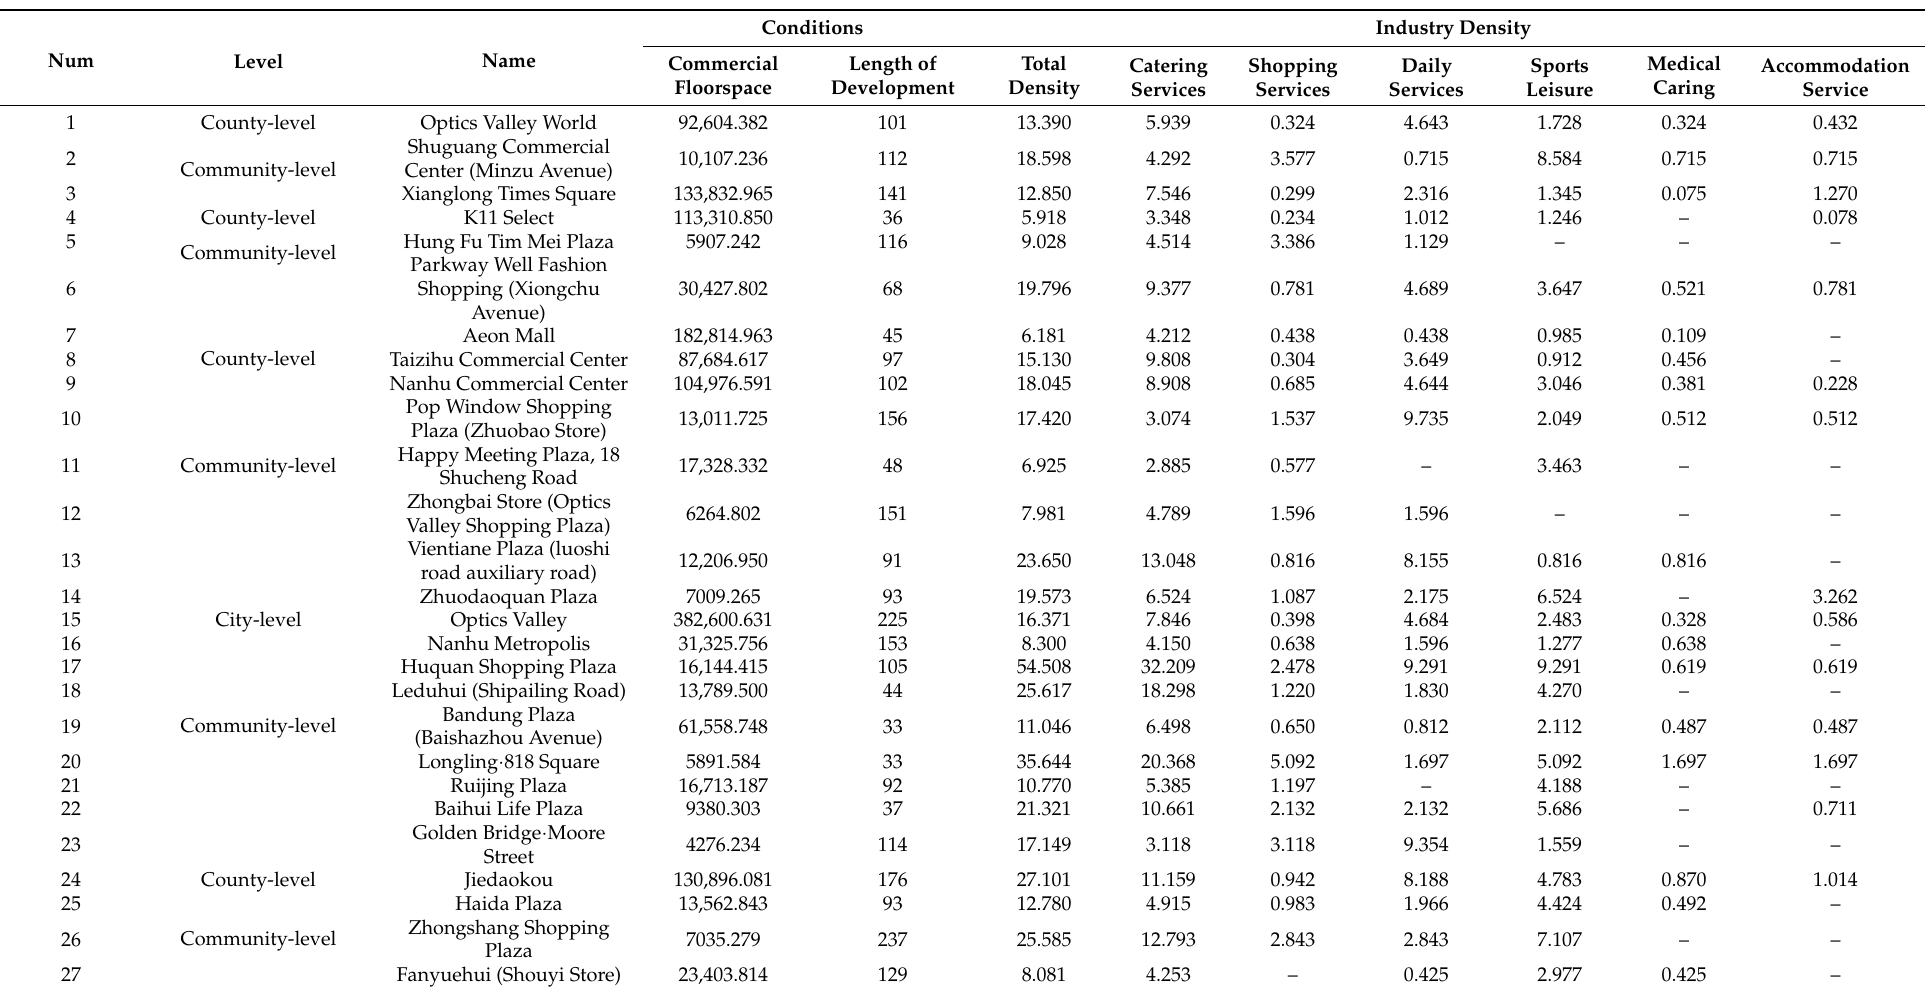
Table 1. Data of 66 defined commercial